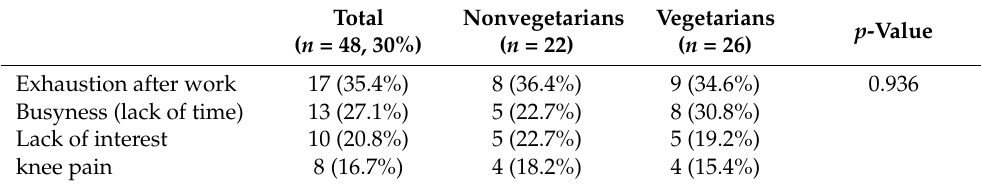
Table 4. Main reasons for low physical activity